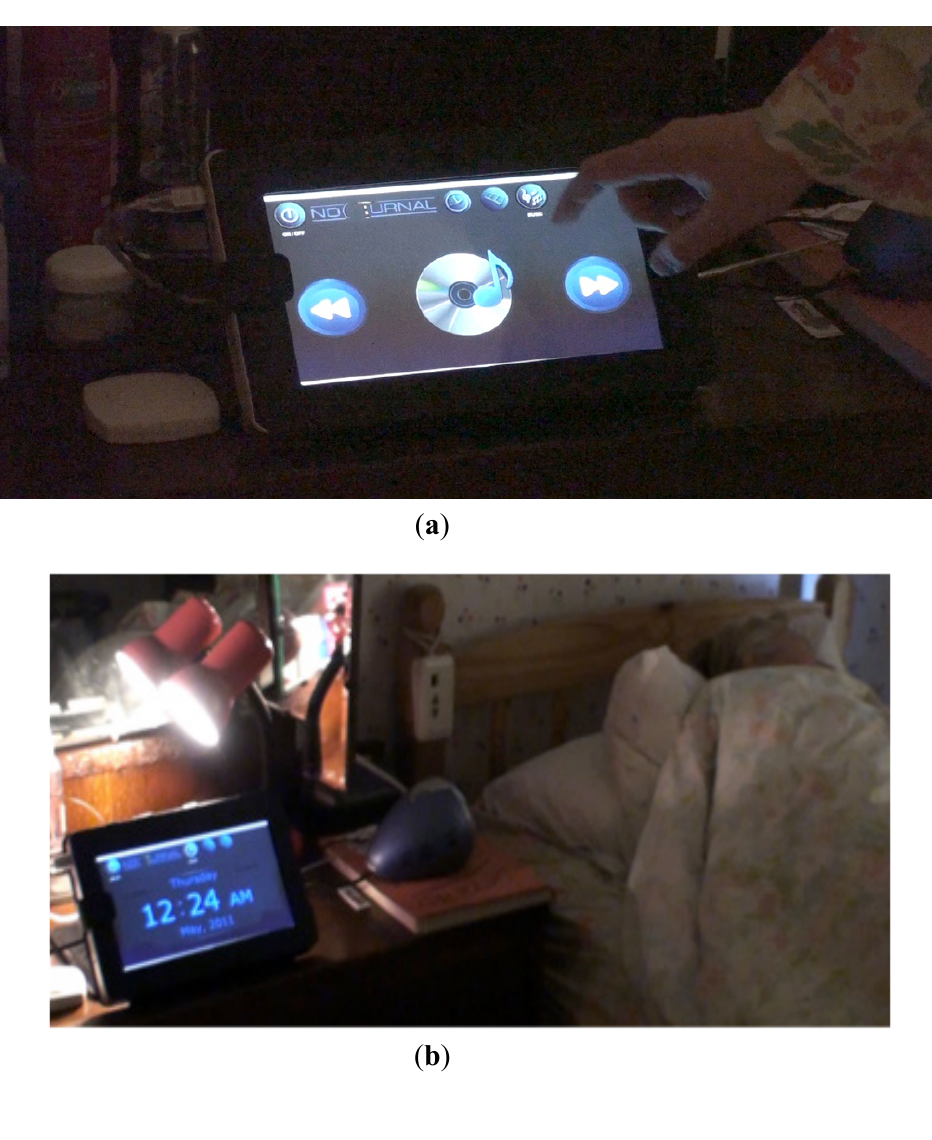
Figure 1. ( a ) Participant navigating through tablet to select personalized music; ( b ) Tablet PC on user’s bedside